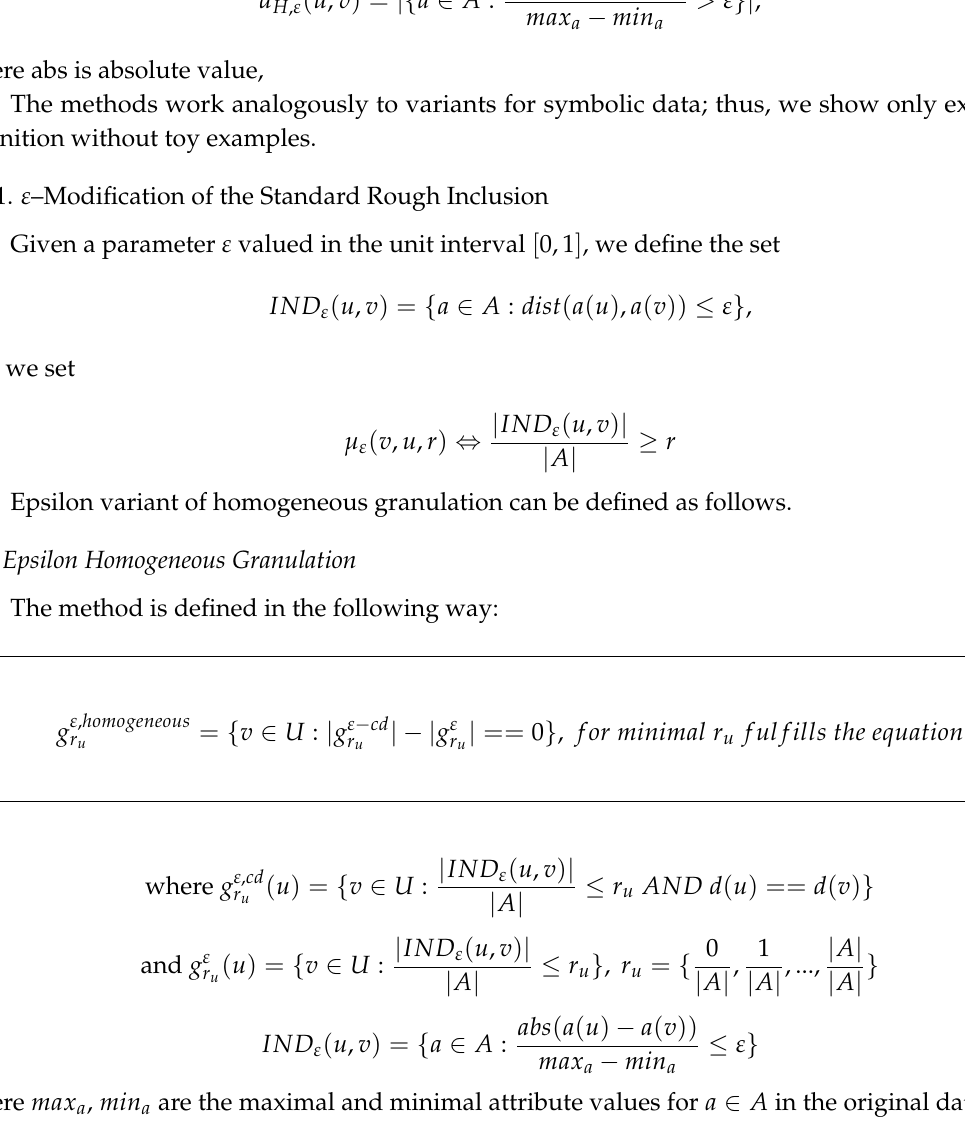
Table 9. The decision system ( U l